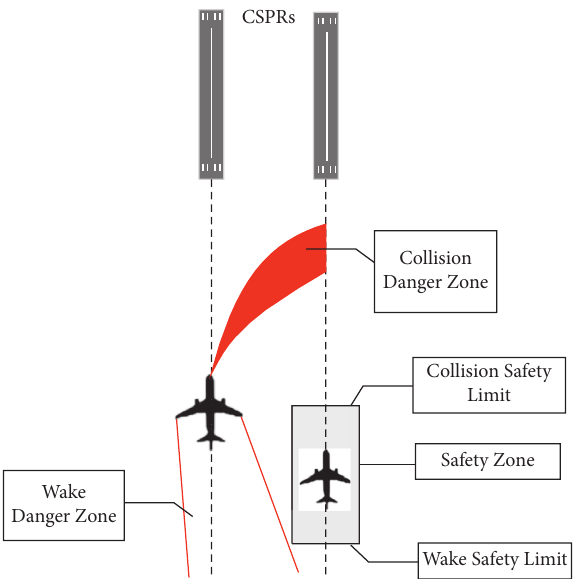
Figure 1: Schematic diagram of paired approach